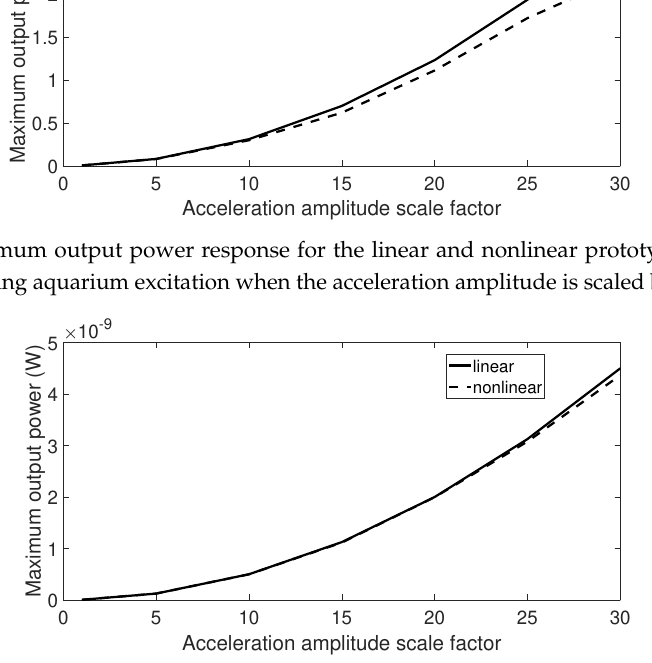
Figure 17. Maximum output power response for the linear and nonlinear prototypes under center frequency sweeping acoustic guitar excitation when the acceleration amplitude is scaled by a